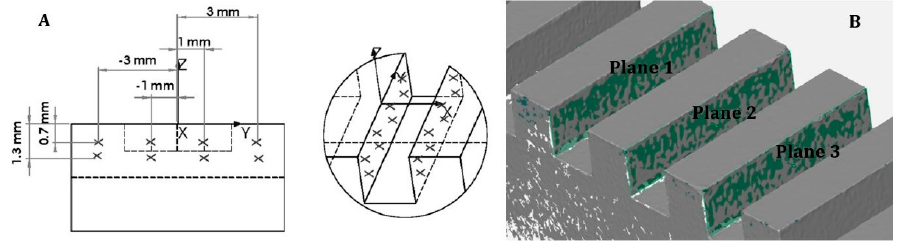
Figure 3. Coordinate measuring machine (CMM) probing strategy ( A ) and least square fitting procedure on acquired data with non-contact instruments ( B ). Sensors 2020 , 20 , 738